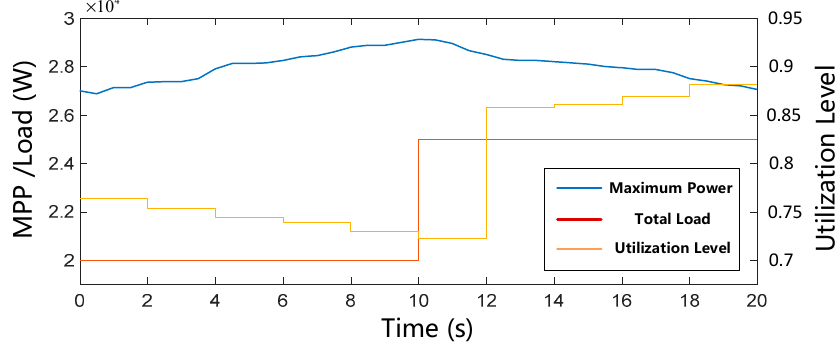
Figure 13. Maximum power, load, and utilization level profiles.